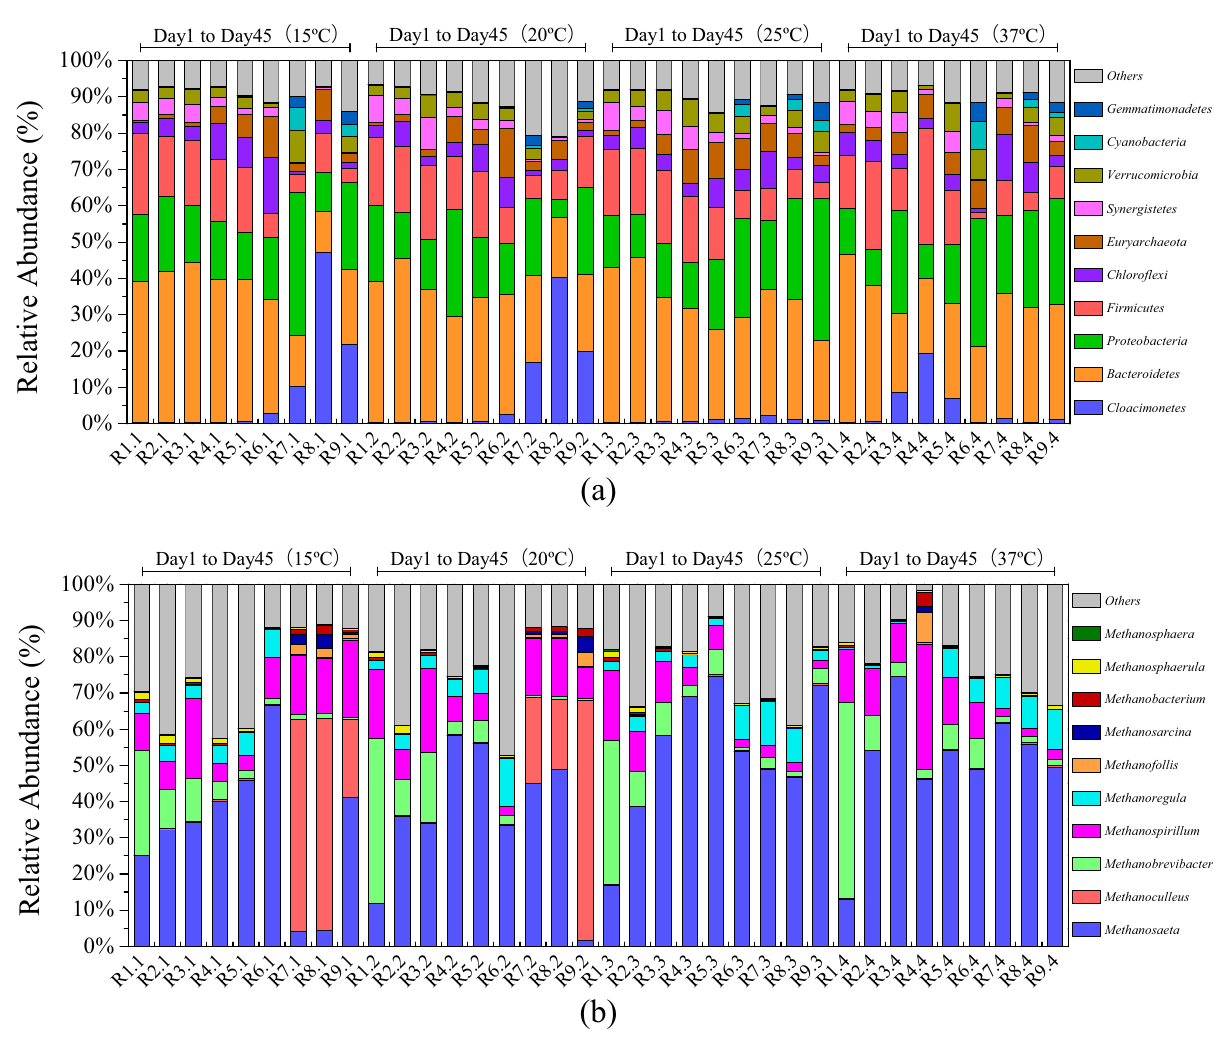
Figure 4: Relative abundance changes of the microbial community at phylum levels ( a ) and the methanogenic microbial community at the genus level ( b ) in the anaerobic digestion of cattle manure at sub - mesophilic